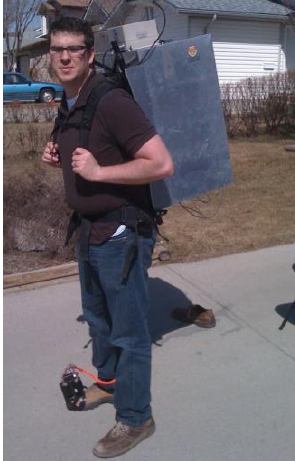
Figure 6. Rigidly Mounted IMUs on the